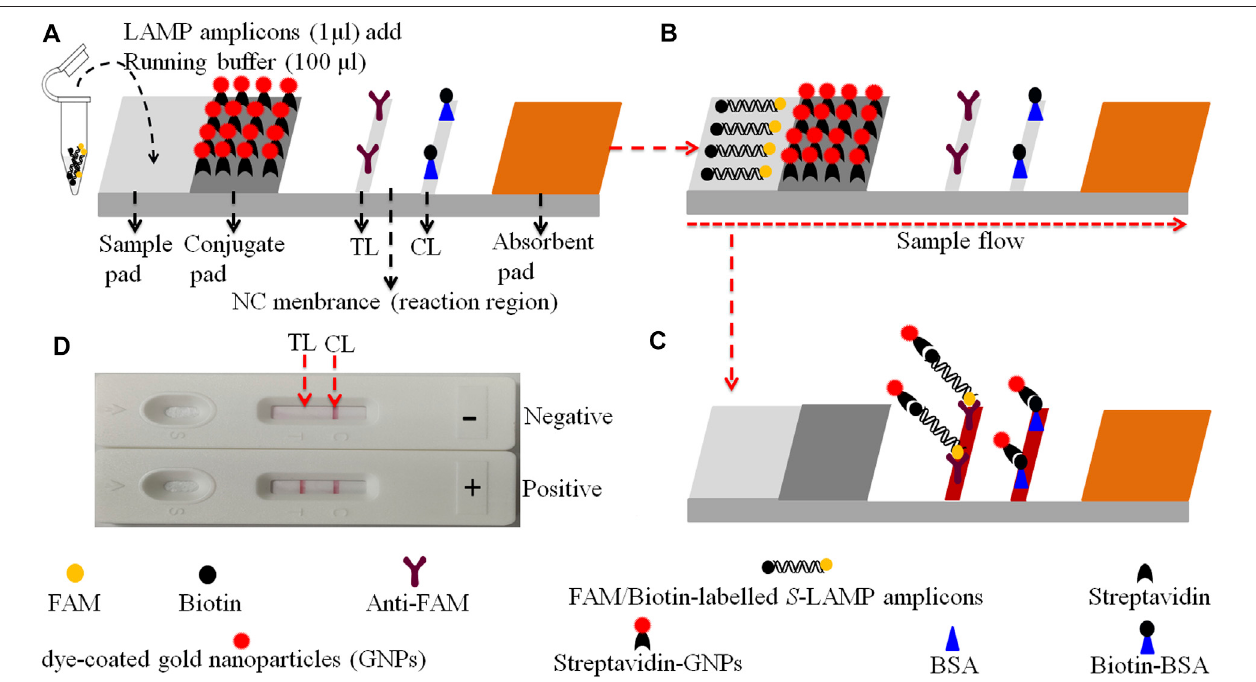
FIGURE 2 | The schematic of the gold nanoparticle-based LFB for the visualization of HVB-LAMP-LFB products. (A) The biotin/FAM-labeled HBV-LAMP amplicons (1.0 μ L)and the running buffer (100 μ L) were added to the sample pad. (B) The running buffer containing LAMP products will be moved along the LFB owing to capillary action; meanwhile, the dye streptavidin-coated gold nanoparticles (streptavidin-GNPs) were rehydrated on the conjugate region. (C) In the positive sample, the biotin/FAM-labeled HBV-LAMP amplicons were captured by the anti-FAM at the TL and the streptavidin-GNPs were captured by the biotin-BSA at the CL, respectively.However,innegativeresults,onlythestreptavidin-GNPswerecapturedbybiotin-BSAattheCL. (D) InterpretationoftheHBV-LAMP-LFBassayresults.For positive results, CL and TL appear on the biosensor, whereas only the CL was observed on the biosensor, indicating negative outcomes.